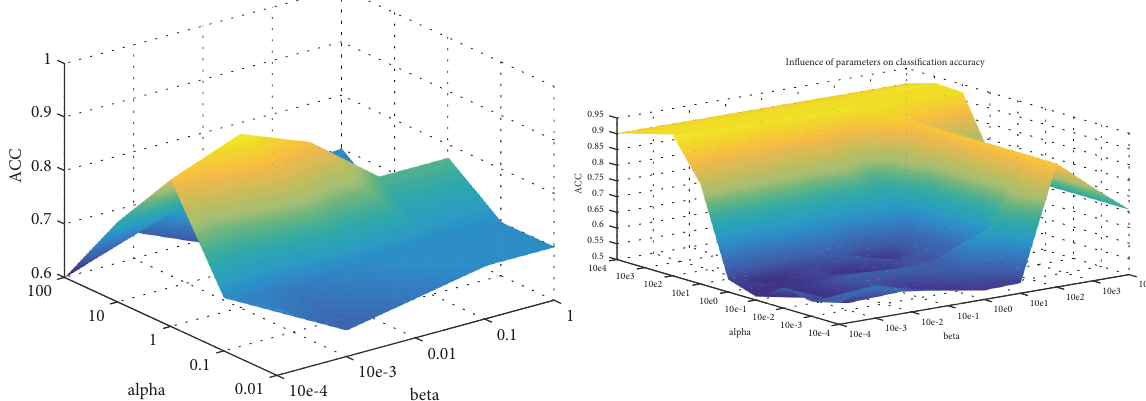
Figure 1: The influence of parameters on classification ACC (INTA 1 and INTA 2).